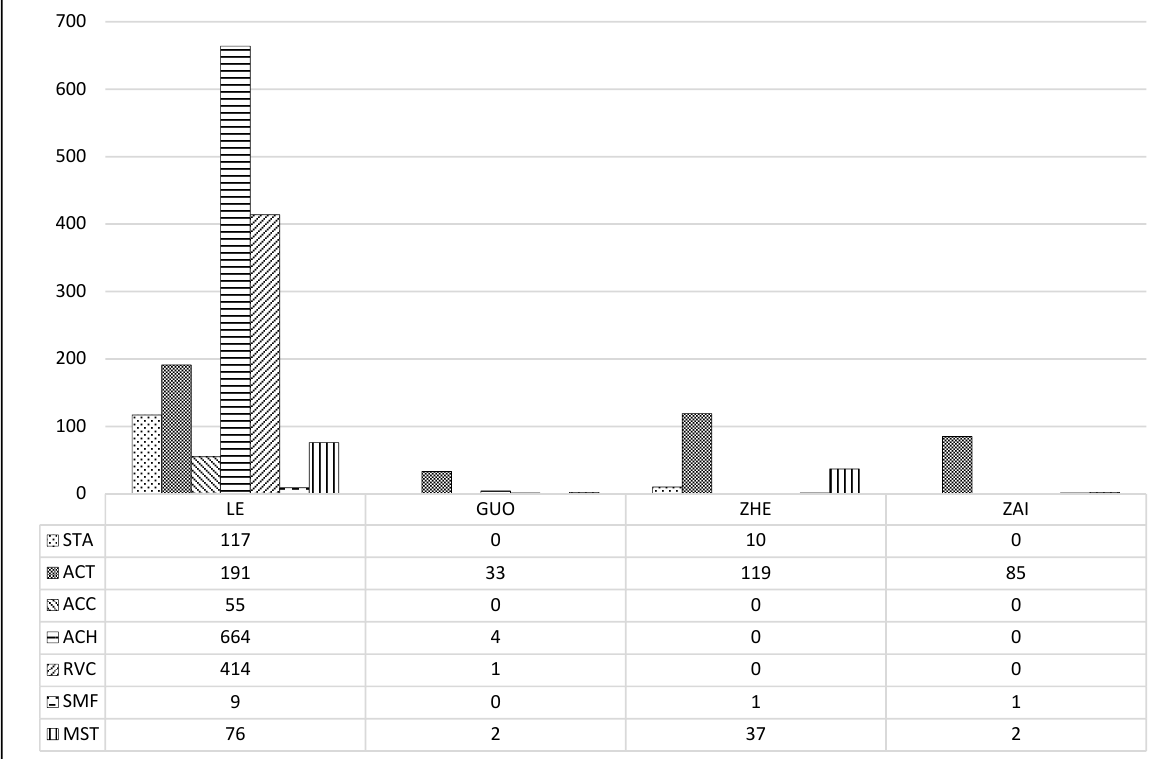
Figure 1. Frequency of grammatical aspect markers and lexical aspect subclass combinations. Note. STA = States, ACT = Activities, ACC = Accomplishments, ACH = Achievements, RVC = Resultative compounds, SMF = Semelfactives, and MST = Mixed stative-telic.